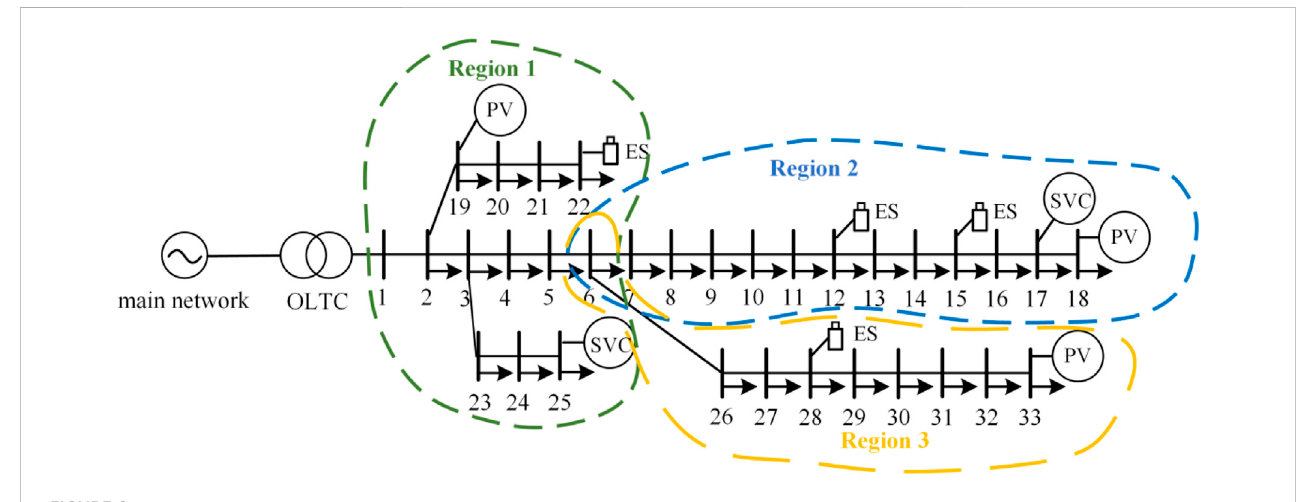
FIGURE 8 DN topology of the IEEE-33